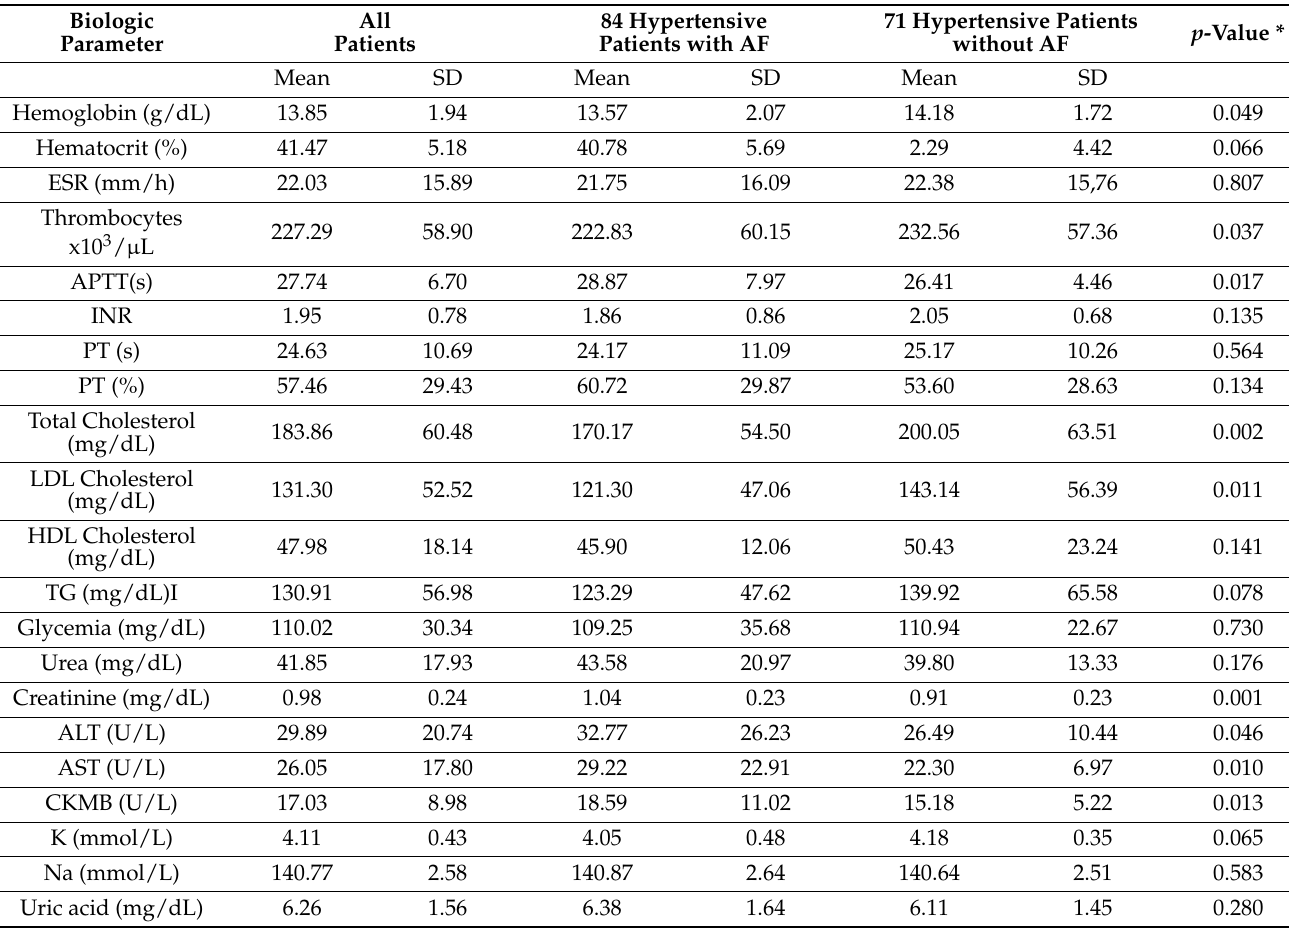
Table 2. Biological parameters in hypertensive patients with AF and hypertensive patients without AF.